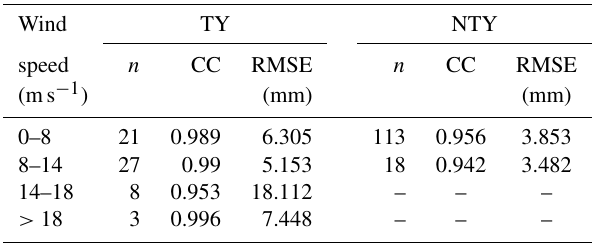
Table 1. The JWD and rain gauge comparison results ( n – num- ber of rainy days; CC – correlation coefficient; RMSE – root mean square error) for different wind speed conditions (daily maximum wind speed is 0–8, 8–14, 14–18, and > 18ms − 1 ). Note that